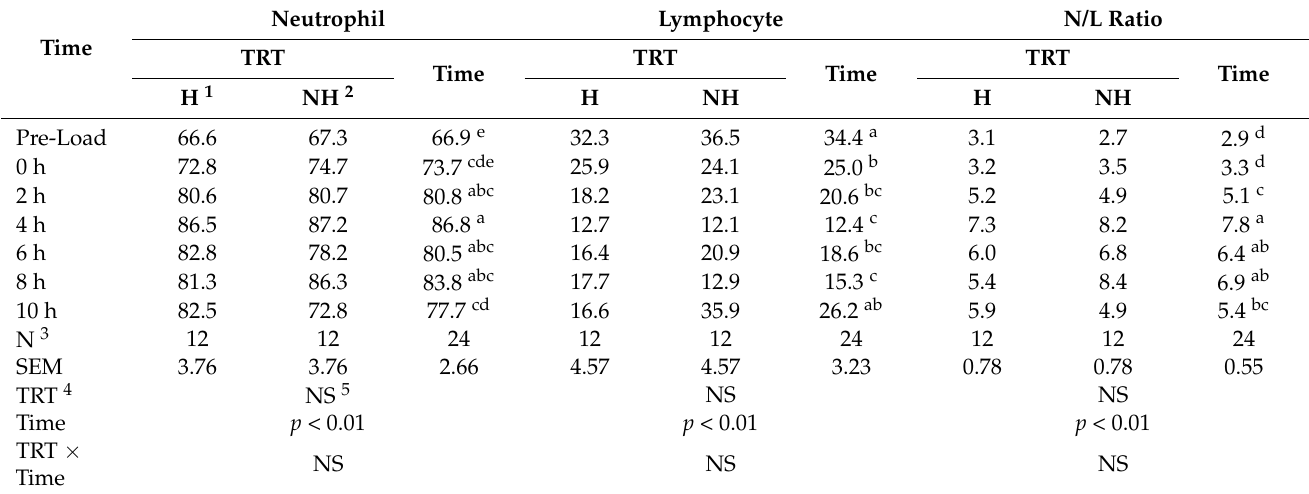
Table 2. Effects of habituation to livestock trailer on neutrophil (N) and lymphocyte (L) counts and N/L ratio in Spanish